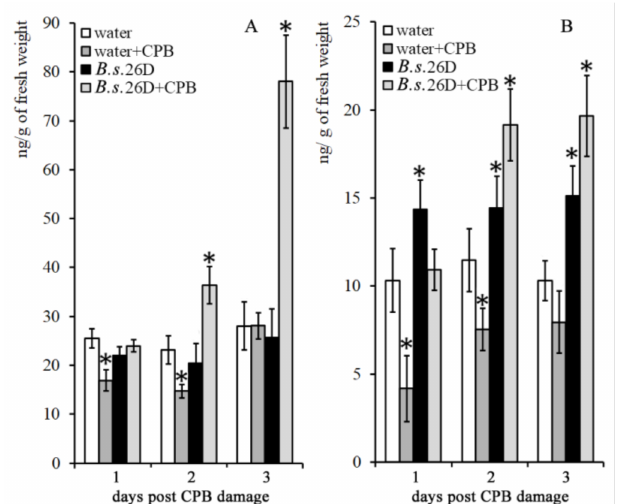
Figure 4. Influence of B. subtilis 26D on the level of zeatin ( A ) and zeatin–riboside ( B ) in potato plants on the 1st, 2nd and 3rd day after damage caused by CPBs. The values are means, and the vertical bars represent standard errors. Data analyzed using two-way ANOVA with Tukey’s post hoc test. Asterisks indicate means statistically different from the control at p ≤ 0.05. c—control plants (water-treated intact plants); CPB—plants damaged by Colorado potato